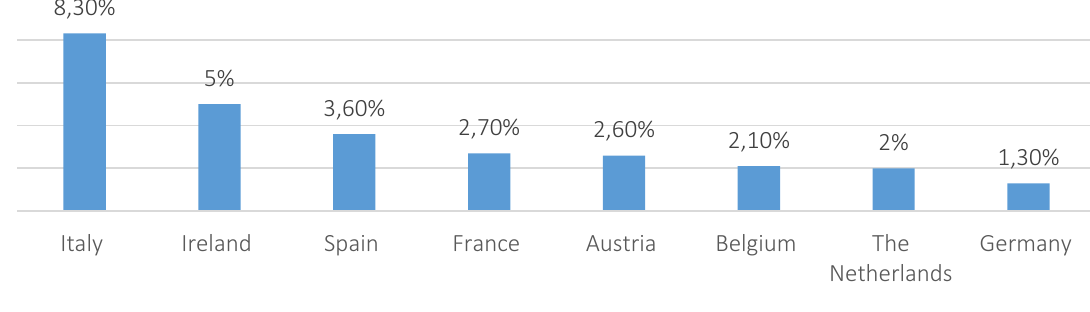
Figure 1. NPL ratio in Western Europe (March